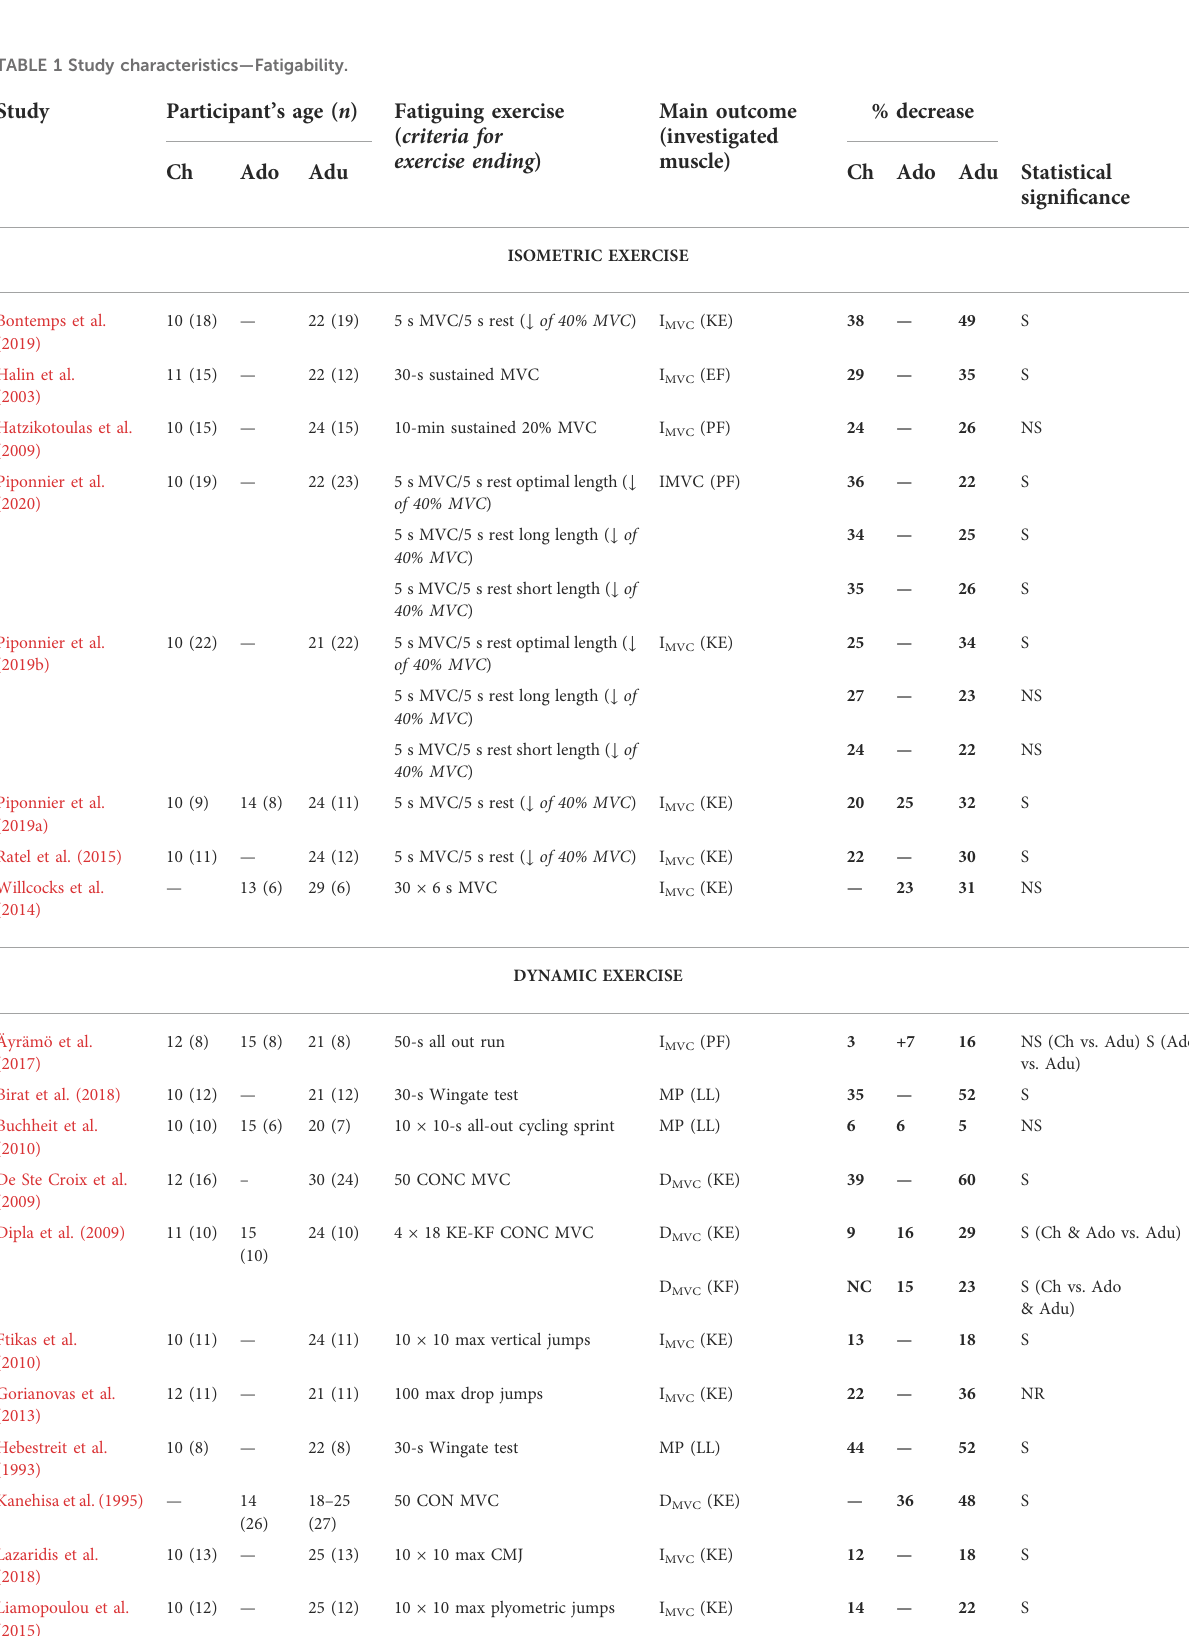
TABLE 1 Study characteristics —